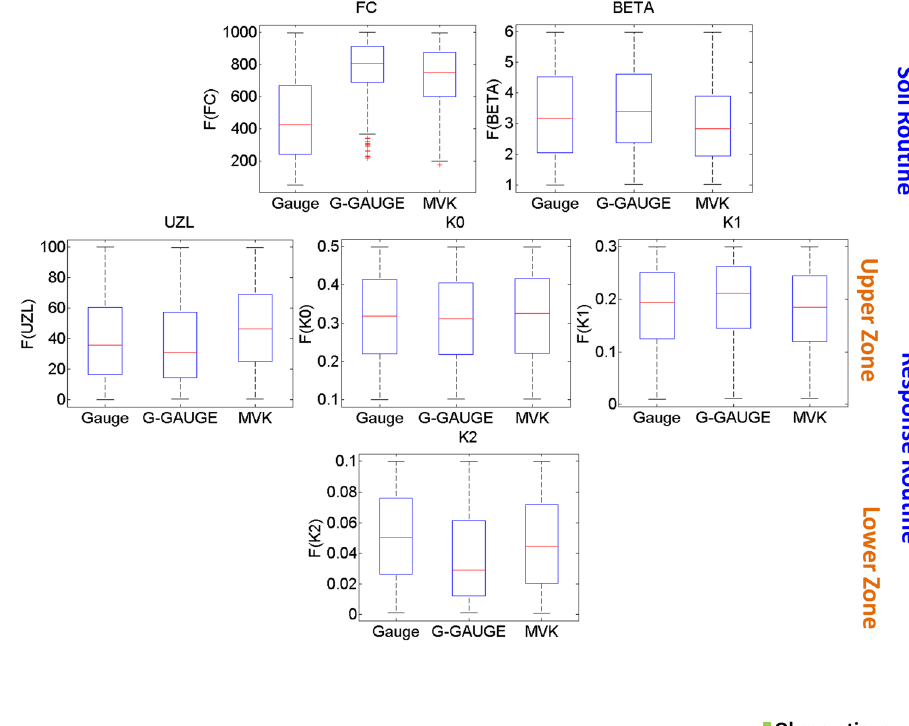
Fig. 11 Model performances a R 2 and b NS in 4 river basins of rainfall observations (green columns), GSMaP-Gauge (blue columns), and GSMaP-MVK (red columns) for calibration period